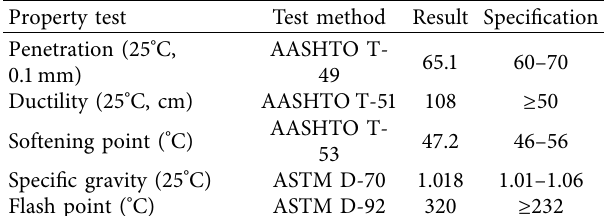
Table 4: Physical properties of mineral